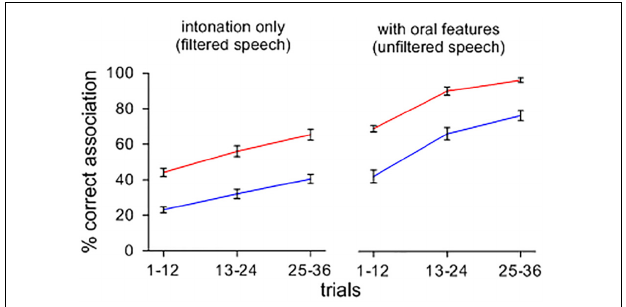
FIGURE 1 | Percent correct sound-picture association for different sets of lexemes presented with and without a filtering of oral features. Note that, when intoned items are presented with their oral features, symbolic associations rise more quickly and more accurately across feedback